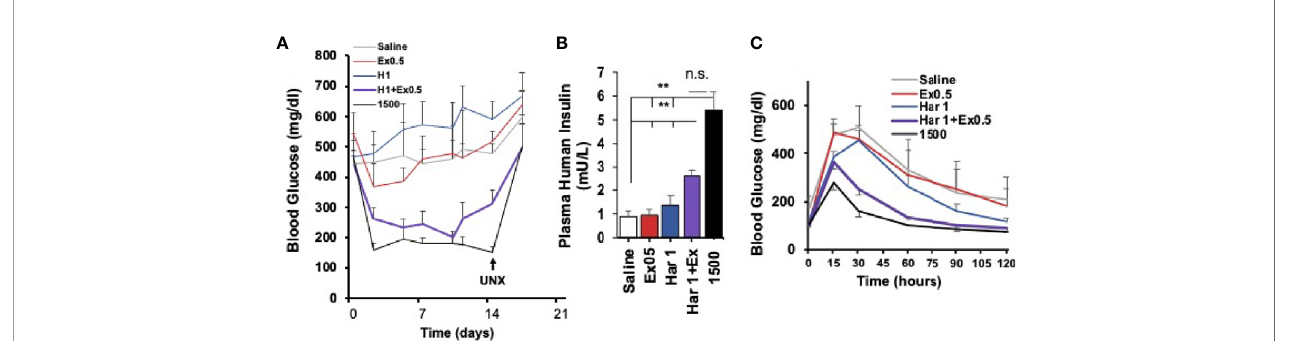
FIGURE 7 | Effects of The Harmine-GLP1 Combination on Human Beta Cell Function In Vivo . (A) Using a standard marginal mass human islet transplant model in streptozotocin (STX) diabetic mice, 500 human islets were transplanted into the renal capsule of immunode fi cient mice, which were then treated intraperitoneally for two weeks with saline, harmine (1 mg/kg/d), the stable GLP1 analogue, exendin-4 (0.5 µg/kg/d) or the harmine-exendin-4 combination. Mice transplanted with 1500 human islets served as a positive control. Note that saline, harmine alone or exendin-4 alone had little effect on blood glucose in the diabetic mice, but the harmine- exendin-4 treatment resulted in a marked improvement, approaching the ef fi cacy of the 1500 islet group. Diabetes recurred following unilateral nephrectomy (UNX) of the human islet graft, con fi rming that glycemic control resulted from enhanced function of the human graft, and not from endogenous mouse beta cells. (B) Human insulin measurements in the fi ve groups on day 14. Note that human insulin concentrations were three times higher in harmine + exendin-4 group than the harmine or exendin-4 alone groups, but not as high as in the mice receiving 1500 human islets. (C) Intraperitoneal glucose tolerance tests at day 14 in the groups in (A) Glycemic control is much improved in the animals receiving the harmine-exendin-4 combination as compared to the saline, harmine only, or exendin-4 only groups, approaching the 1500 islet positive control group. Reproduced with permission from (29), which contains complete details. **p < 0.01; ns, not signi fi